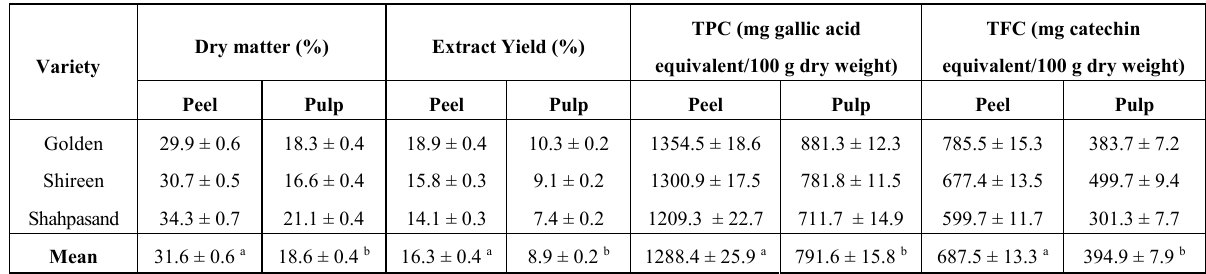
Table 1. Percent extraction yield, total phenolic contents (TPC) and total flavonoid contents (TFC) of peel and pulp extracts from different varieties of peach ( Prunus persica L.)